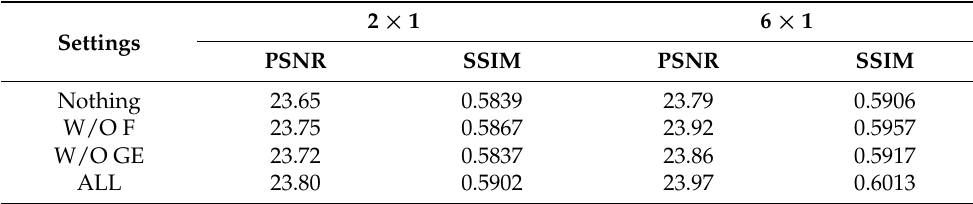
Table 9. The average PSNR and SSIM for the ablation experiment. Each PSNR and SSIM was averaged over the three